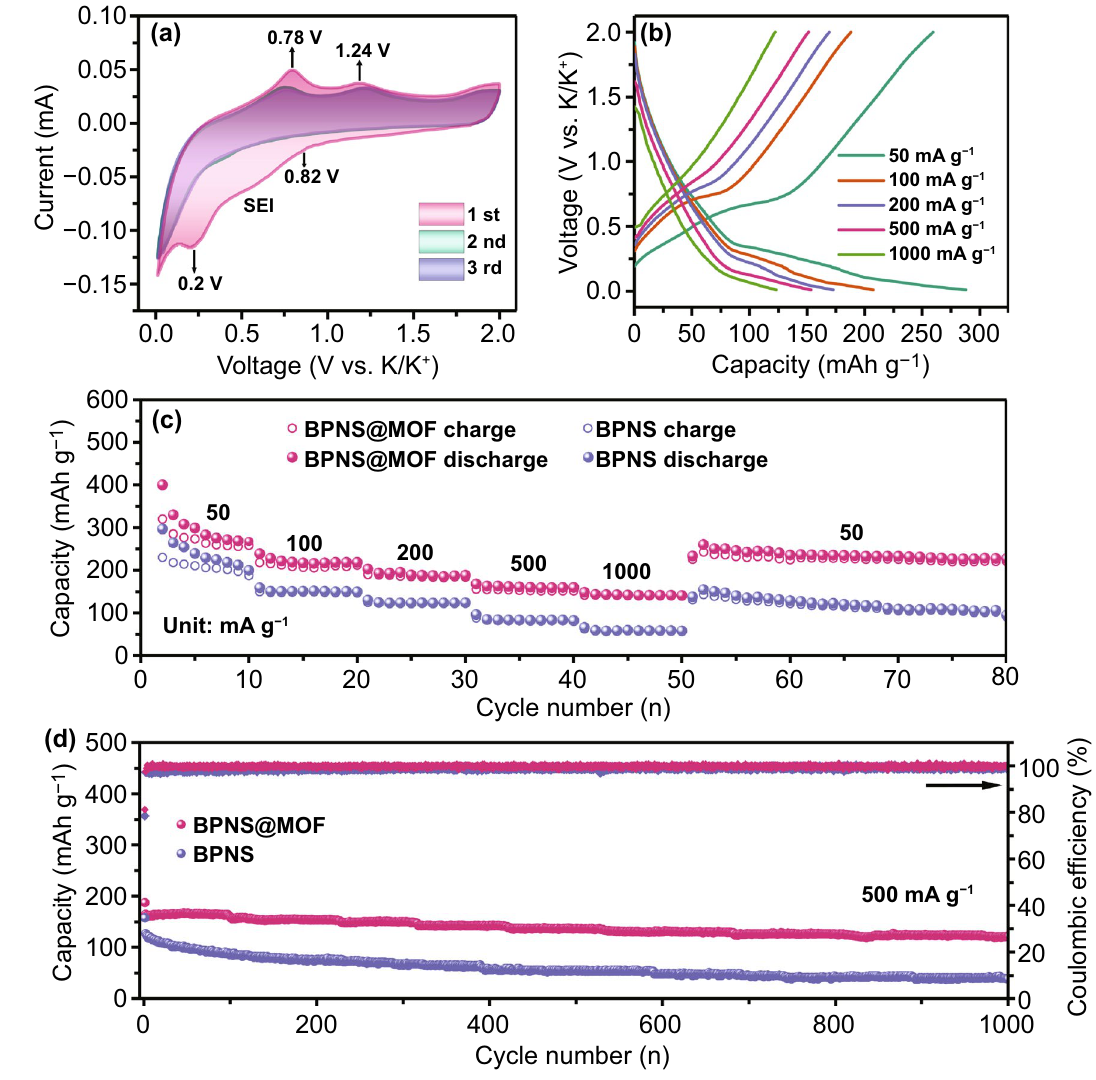
Fig. 4 a CV profiles of the BPNS@MOF electrode at a scan rate of 0.1 mV s −1 for KIB. b Charge–discharge curves of the BPNS@MOF elec- trode in KIB. c Rate performance of the BPNS@MOF and BPNS electrodes in KIB at different current densities from 50 to 1000 mA g −1 . d Cycle performance of the BPNS@MOF and BPNS electrodes in KIB at the current density of 500 mA g